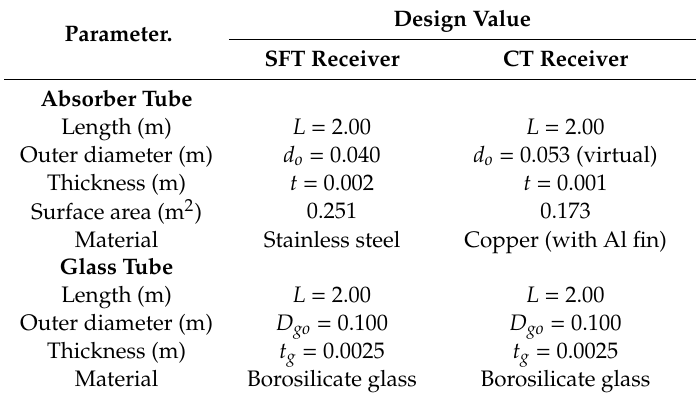
Table 1. Parameters of the single flow through (SFT) and concentric tube (CT) evacuated receivers. Design Value Parameter. SFT Receiver CT Receiver Absorber Tube Length